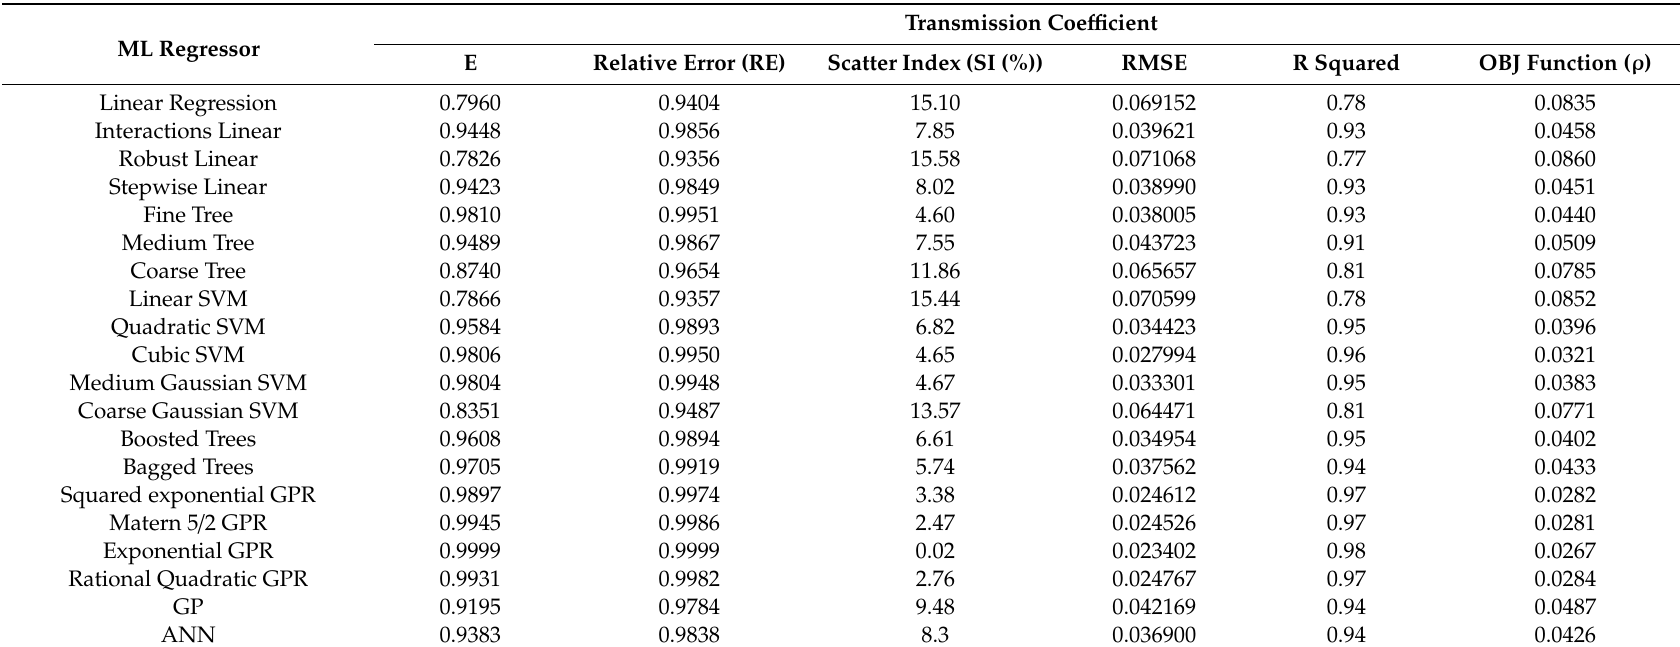
Table 4. Proposed ML regressors and their result for the transmission Coe ffi